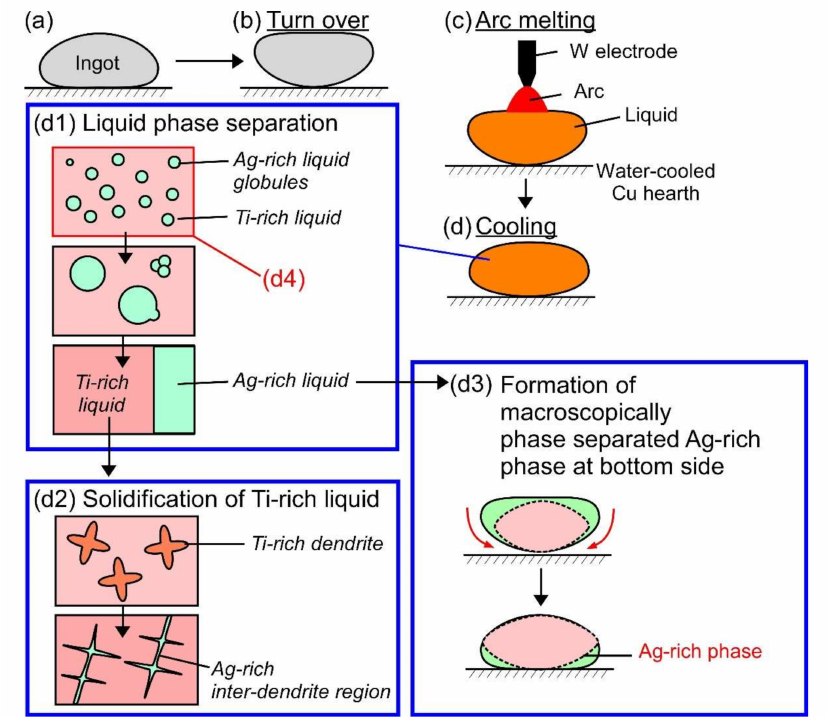
Figure 11. Schematic illustration of the mechanism of the macroscopically phase-separated structure in the arc-melted ingots in the Ti 53.4 Ag 33.3 Nb 13.3 alloy and composite of fine Ag globules and Ti-Nb matrix in the melt-spun ribbons. ( a ) before arc-melting, ( b ) turning over of ingot before arc melting, ( c ) arc melting, ( d ) cooling of the thermal melt, ( d1 ) liquid phase separation and aggregation of minor Ag rich liquid globules, ( d2 ) solidification of Ti-rich liquid, ( d3 ) formation of macroscopically phase-separated Ag-rich phase at the bottom, and ( d4 ) the state after the liquid phase separation without starting the aggregation of minor Ag rich liquid